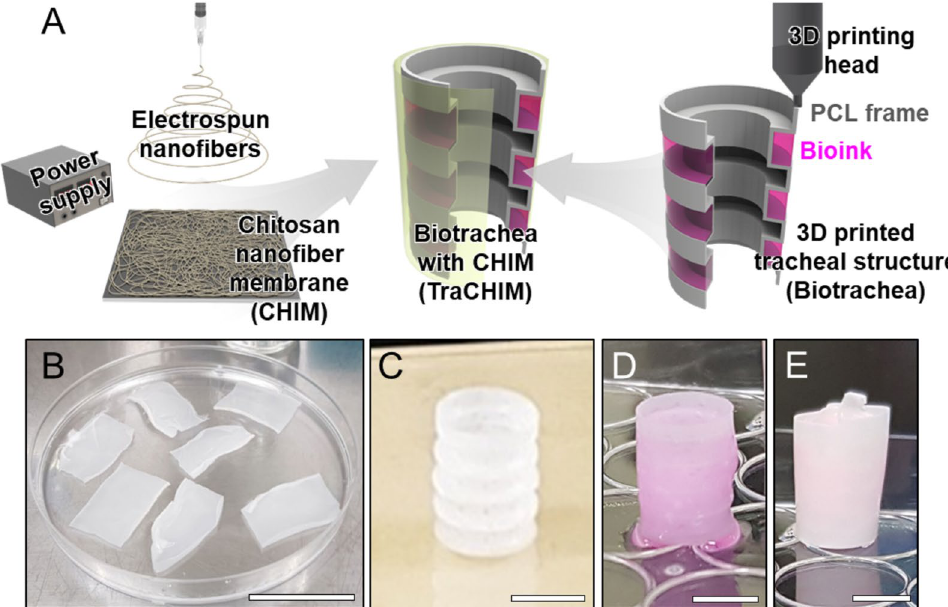
Figure 1. ( A ) Schematic of the fabrication of a 3D-printed tracheal structure (biotrachea) with an electrospun chitosan-based nanofiber membrane (CHIM). Photographs of ( B ) CHIM, ( C ) 3D-printed PCL frame, ( D ) the biotrachea, and ( E ) the biotrachea with CHIM (TraCHIM). Scale bars, 5 cm, 5 mm, 5 mm, and 5 mm,